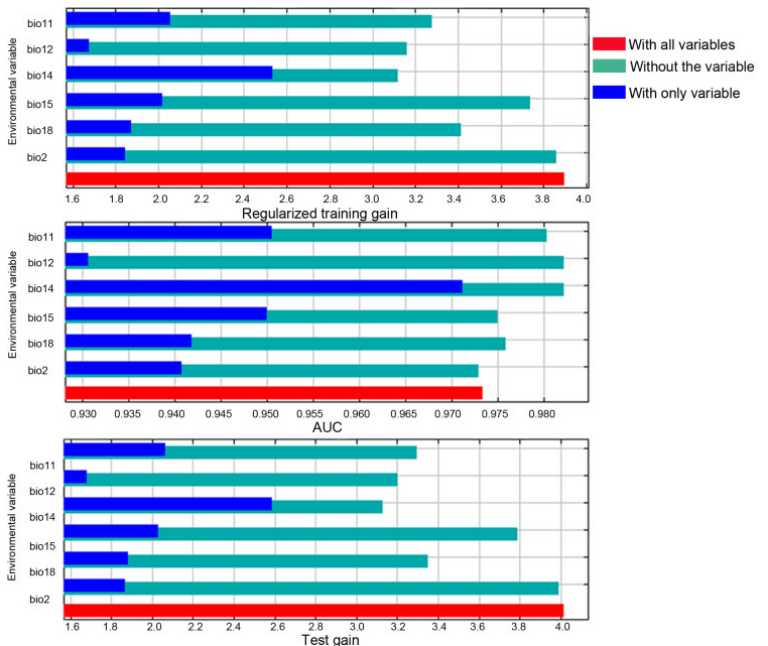
Figure 4. The importance of environmental variables of regularized training gain, AUC, and test gain using the Jackknife test. bio2, Mean Diurnal Range; bio11, Mean Temperature of Coldest Quarter; bio12, Annual Precipitation; bio14, Precipitation of Driest Month; bio15, Precipitation of Seasonality; bio18, Precipitation of Warmest Quarter.